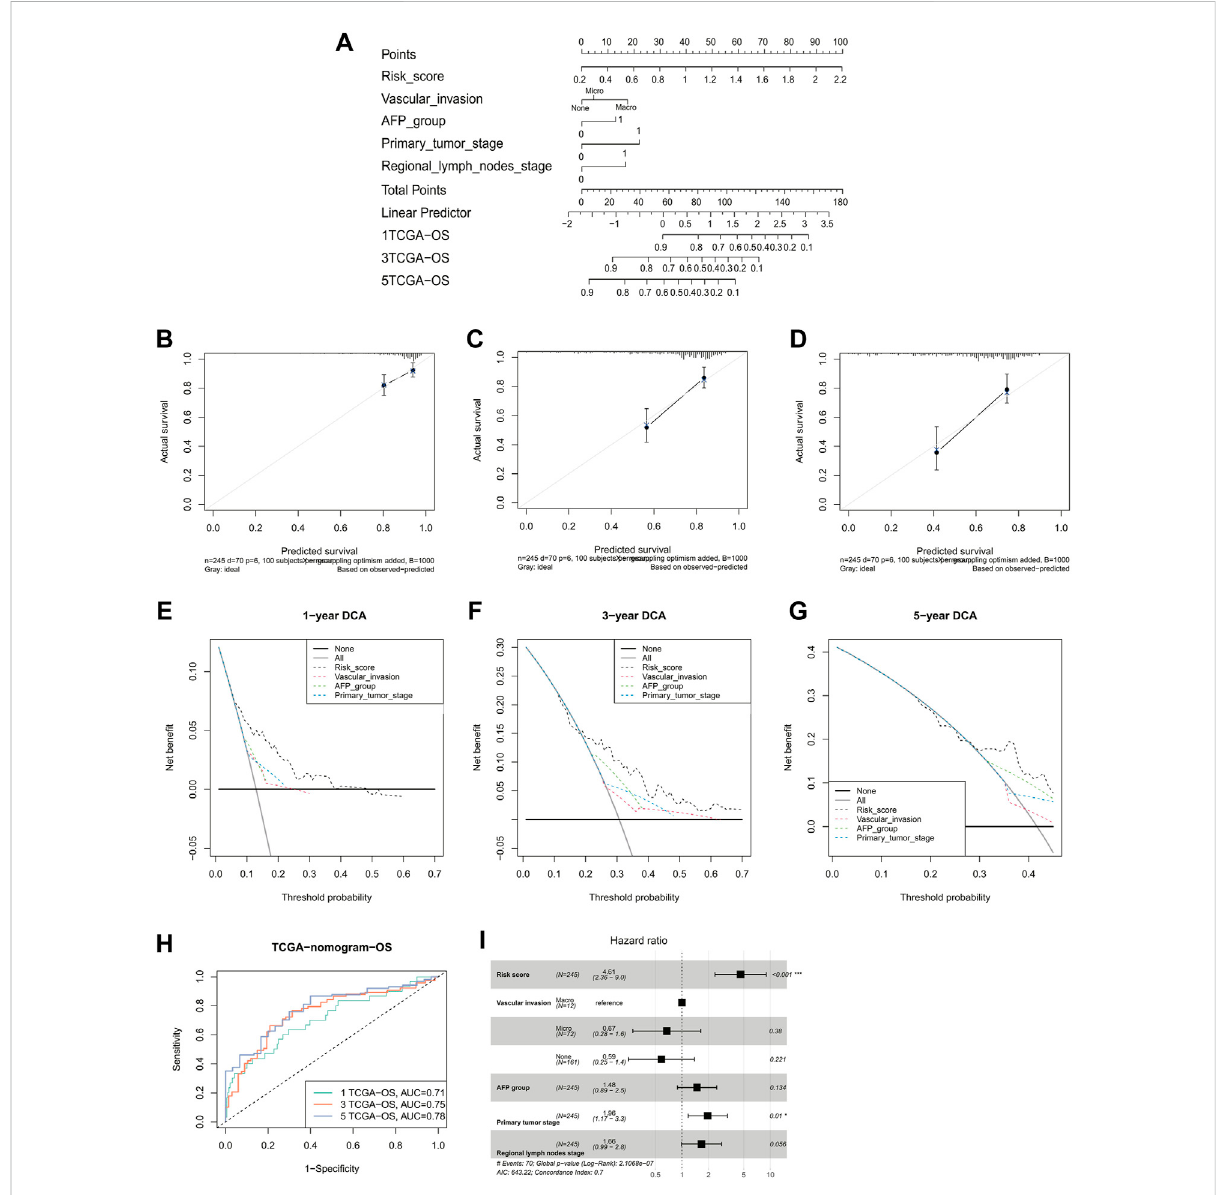
FIGURE 4 Validation of a nomogram-integrated independent predictive factors. (A) Nomogram with a combination of risk scores and different clinical features. A calibration plot for predicting the accuracy of the nomogram in (B) 1-, (C) 3-, (D) and 5-year. (E – G) 1-, 3-, and 5-year DCA analysis of the nomogram. (H) ROC curves of the nomogram for predicting the 1/3/5-year overall survival in TCGA. (I) Multivariate Cox regression analyses of the risk score and clinicopathological factors for overall survival in TCGA. DCA, decision curve analysis; ROC, receiver operating characteristic; TCGA, The Cancer Genome